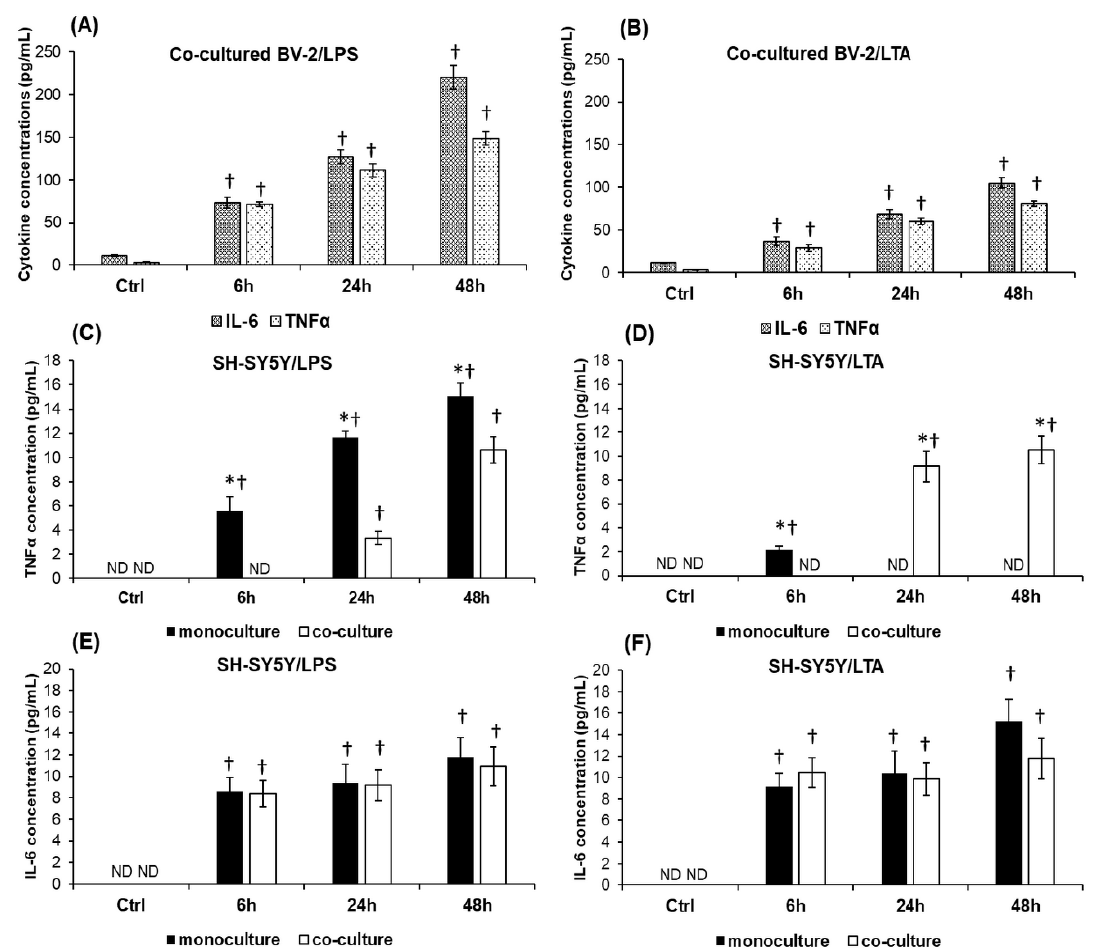
Figure 4. Determination of IL-6 and TNF α secretions of co-cultured BV-2 cells and mono- and co-cultured SH-SY5Y cells. Secreted IL-6 and TNF α concentrations of the culture media were determined with IL-6 and TNF α ELISA Kits specific for human or mouse cytokines. ( A ) IL-6 and TNF α productions of co-cultured BV-2 cells treated with LPS. ( B ) IL-6 and TNF α productions of co-cultured BV-2 cells treated with LTA. ( C ) IL-6 secretions of mono- and co-cultured LPS treated SH-SY5Y cells. ( D ) IL-6 secretions of mono- and co-cultured LTA treated SH-SY5Y cells. ( E ) TNF α secretion of mono- and co-cultured LPS treated SH-SY5Y cells. ( F ) TNF α production of mono- and co-cultured LTA treated SH-SY5Y cells. The columns represent mean values and error bars represent standard errors of the mean (SEM) of three independent determinations. The cytokine contents of the control media did not change during the experiments therefore only one control was represented in each figure. ND stands for not detected. Cross means p < 0.01 compared to the controls. Asterisk marks p < 0.01 between mono- and co-cultures.